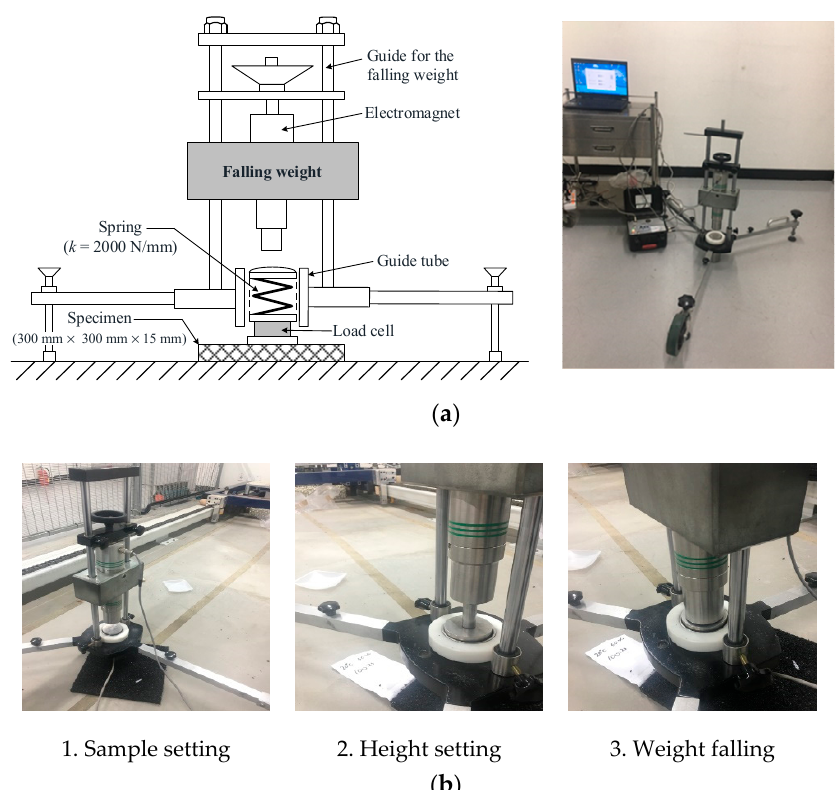
Figure 4. Shock absorption test equipment and procedure: ( a ) Artificial athlete apparatus used for the shock absorption test (impact tester) and ( b ) the shock absorption test procedure.